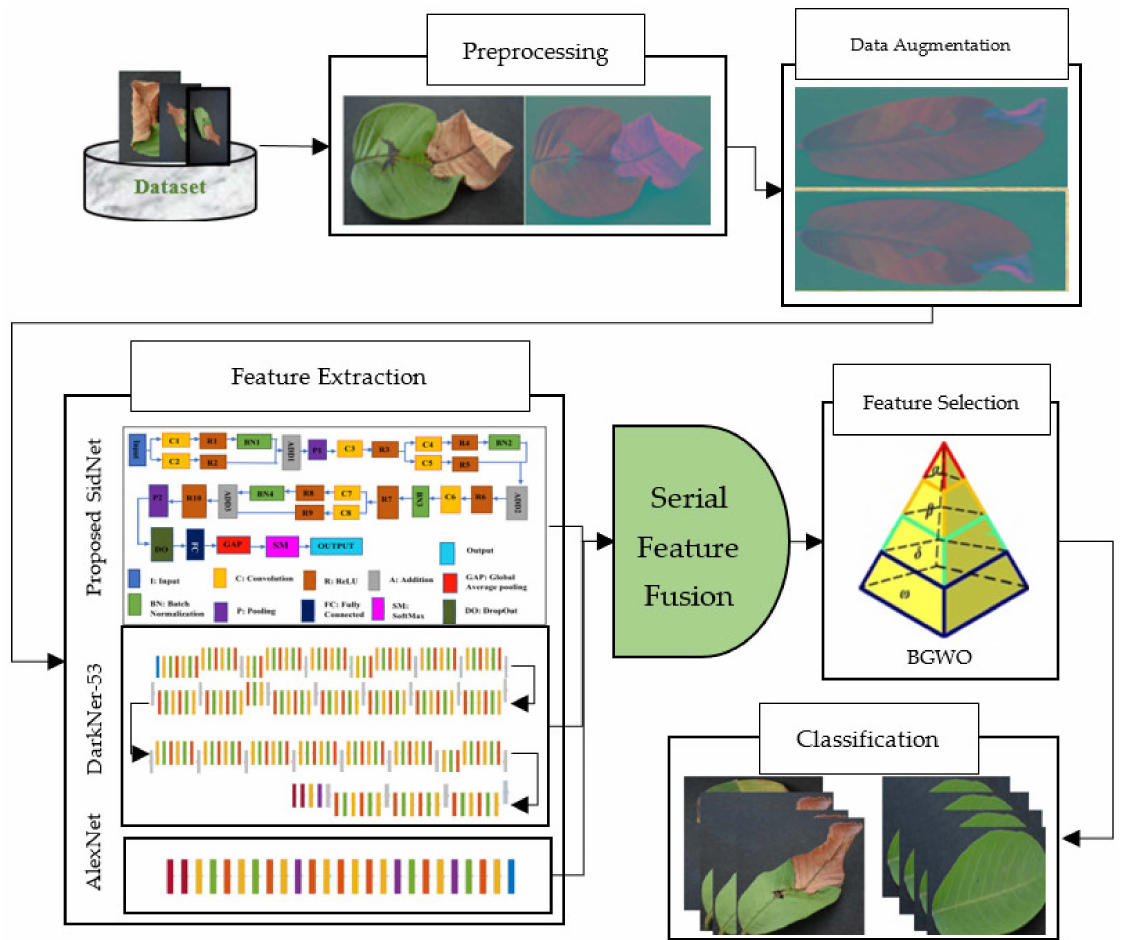
Figure 1. Proposed Framework for disease recognition in guava